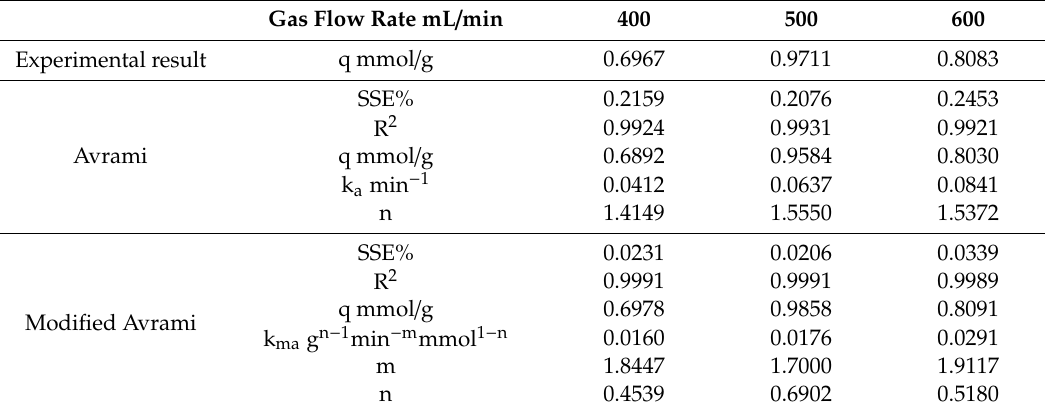
Figure 10. Adsorption characteristics and model fitting results with different gas volumes. Table 8. Fitting parameters of experimental data for different gas adsorption characteristics